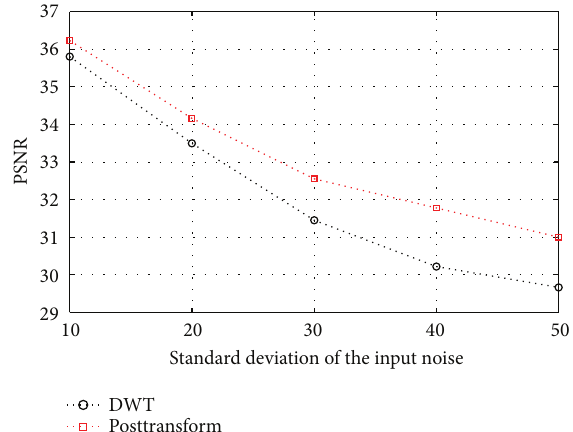
Figure 8: Denoising performance with both DWT and posttrans- form method.